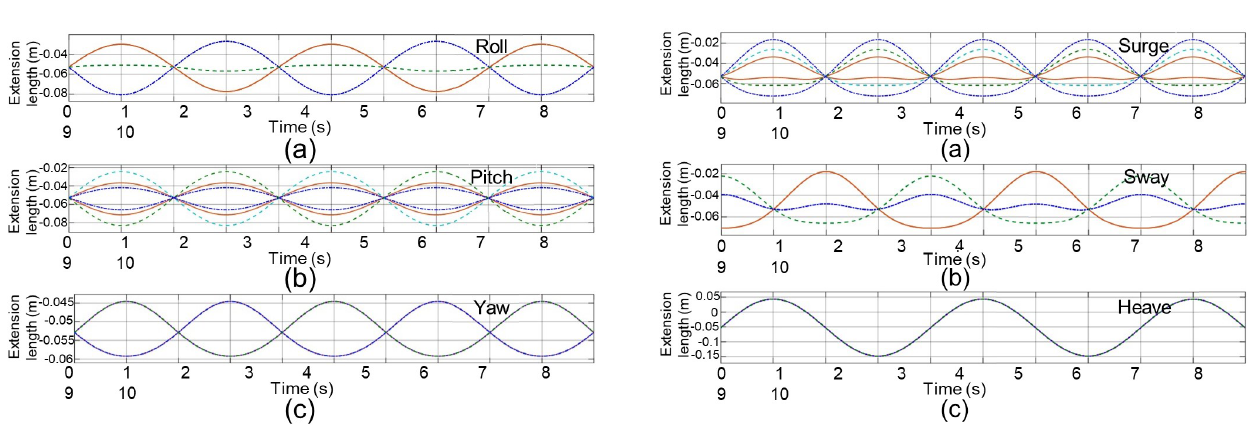
Figure 3. Extension of chains: (a) roll, (b) pitch, and (c) yaw. Figure 4. Extension of chains: (a) surge, (b) sway, and (c) heave.